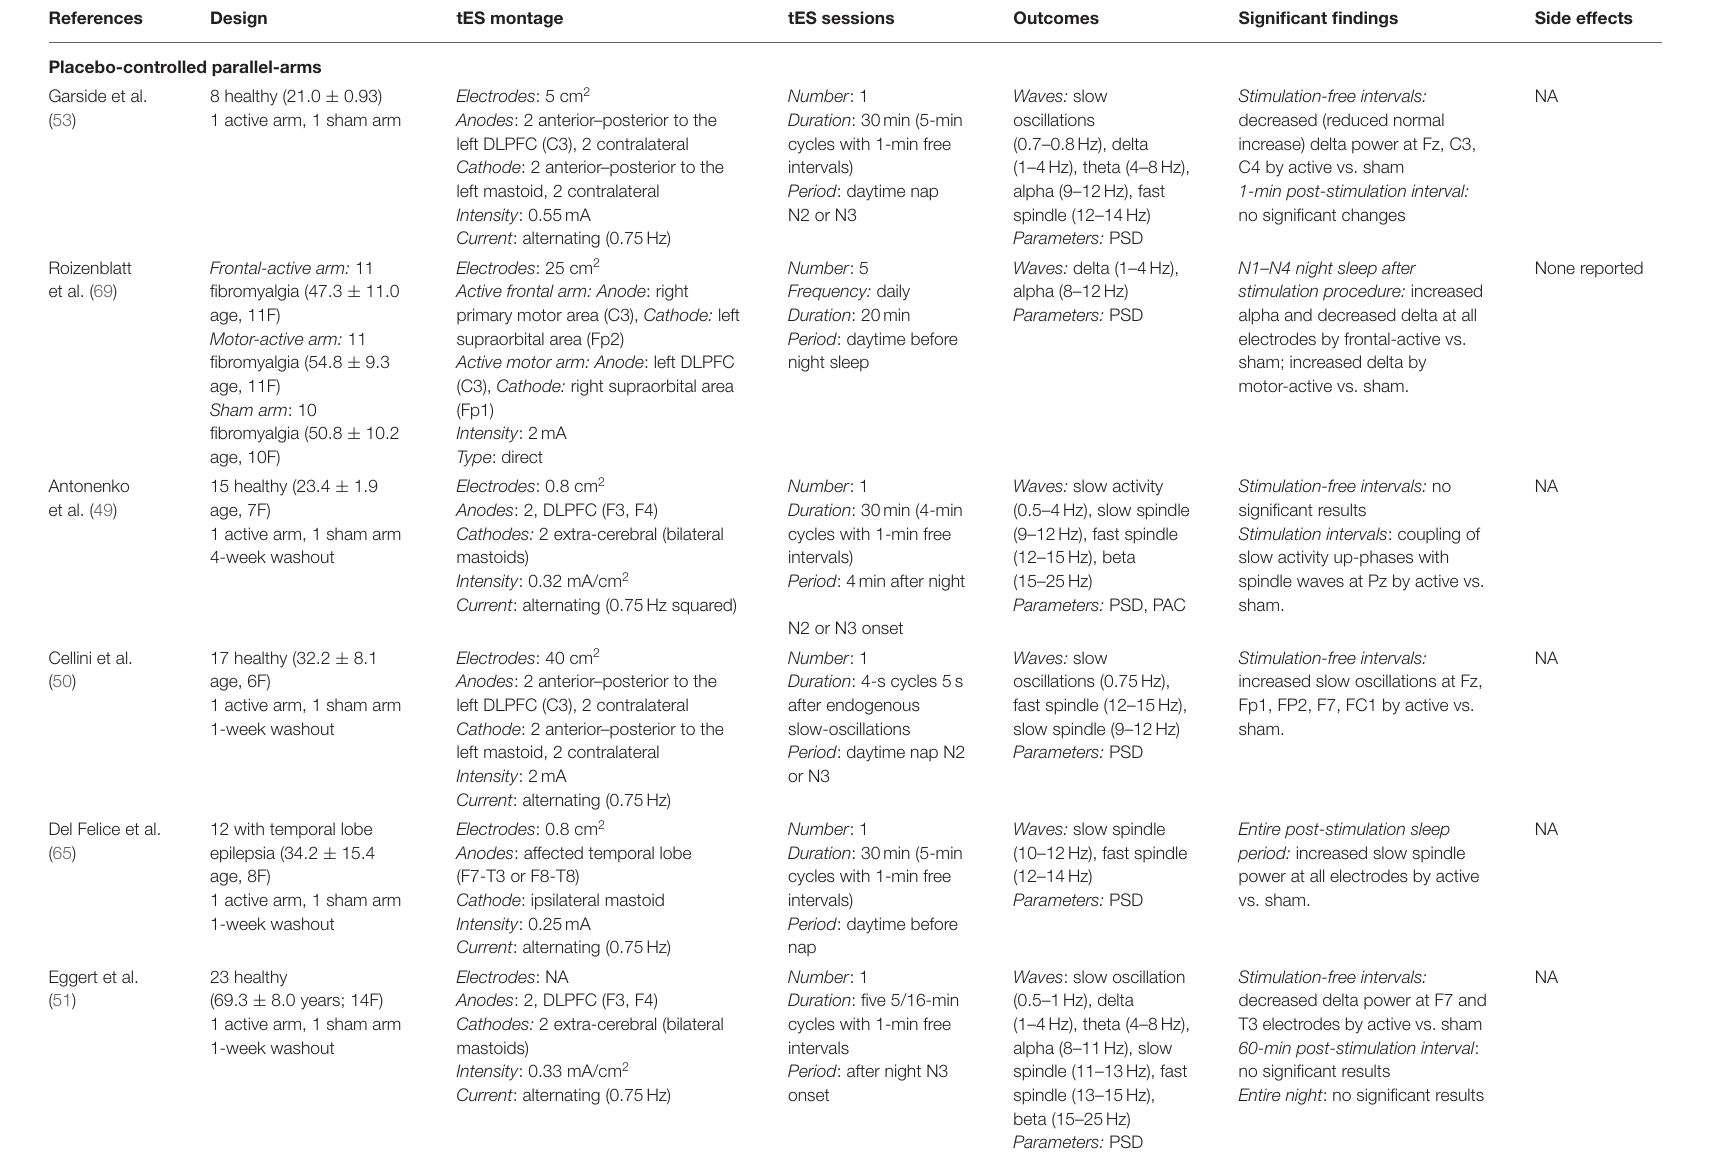
TABLE 1 | Impact of transcranial electrical stimulation on oscillatory aspects of